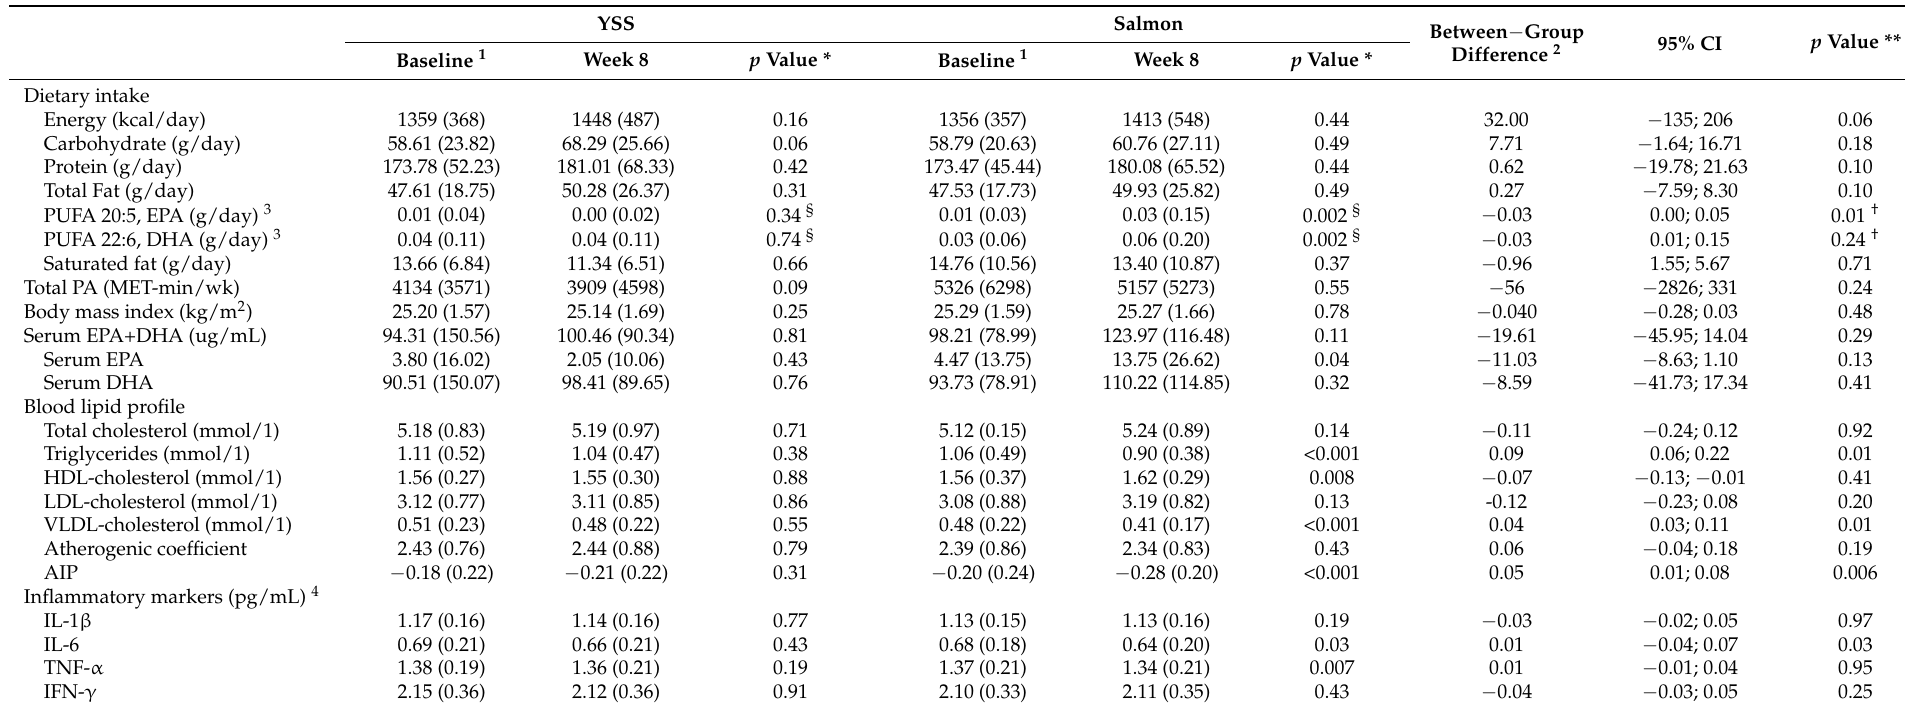
95% CI p Value ** Difference 2